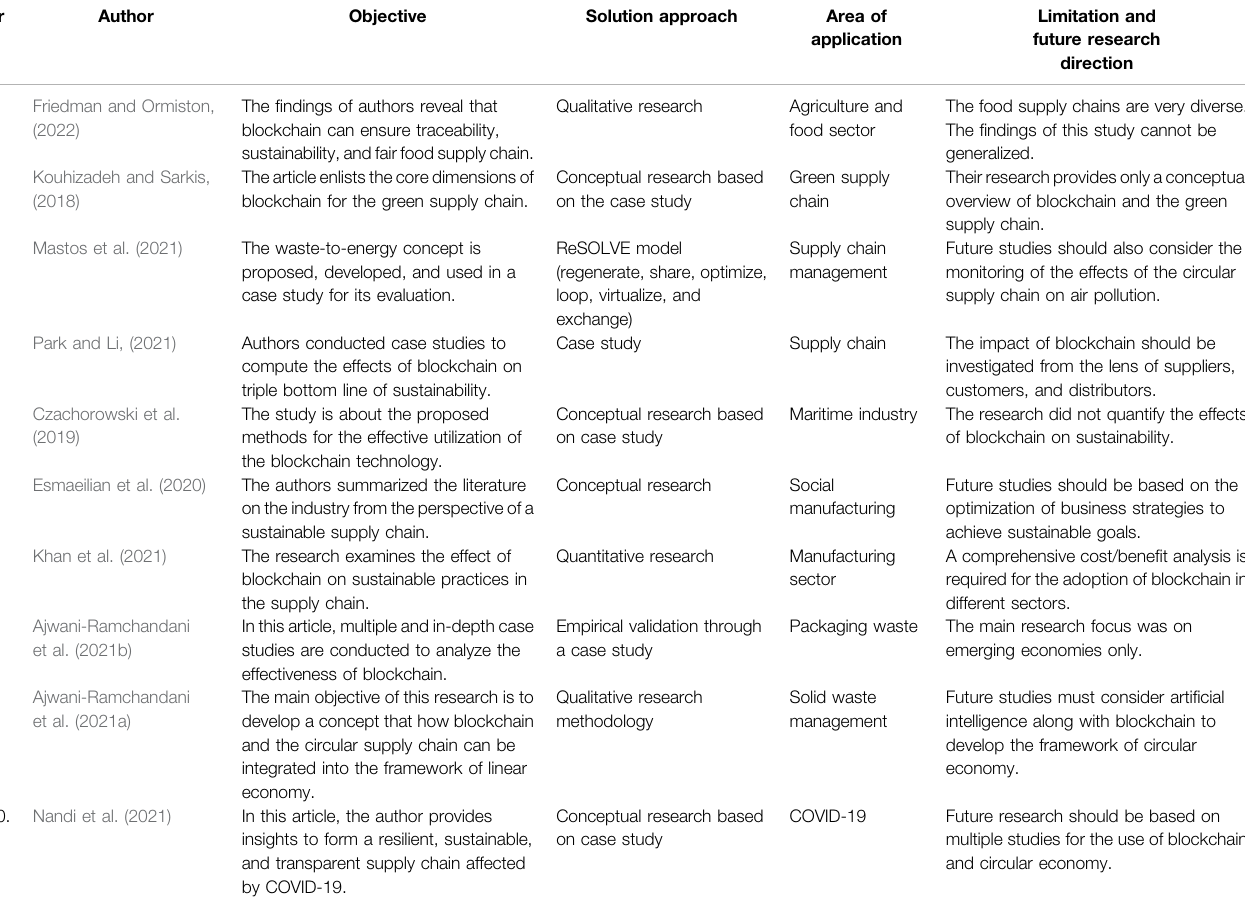
TABLE 7 | Case studies for the blockchain-based green/circular supply